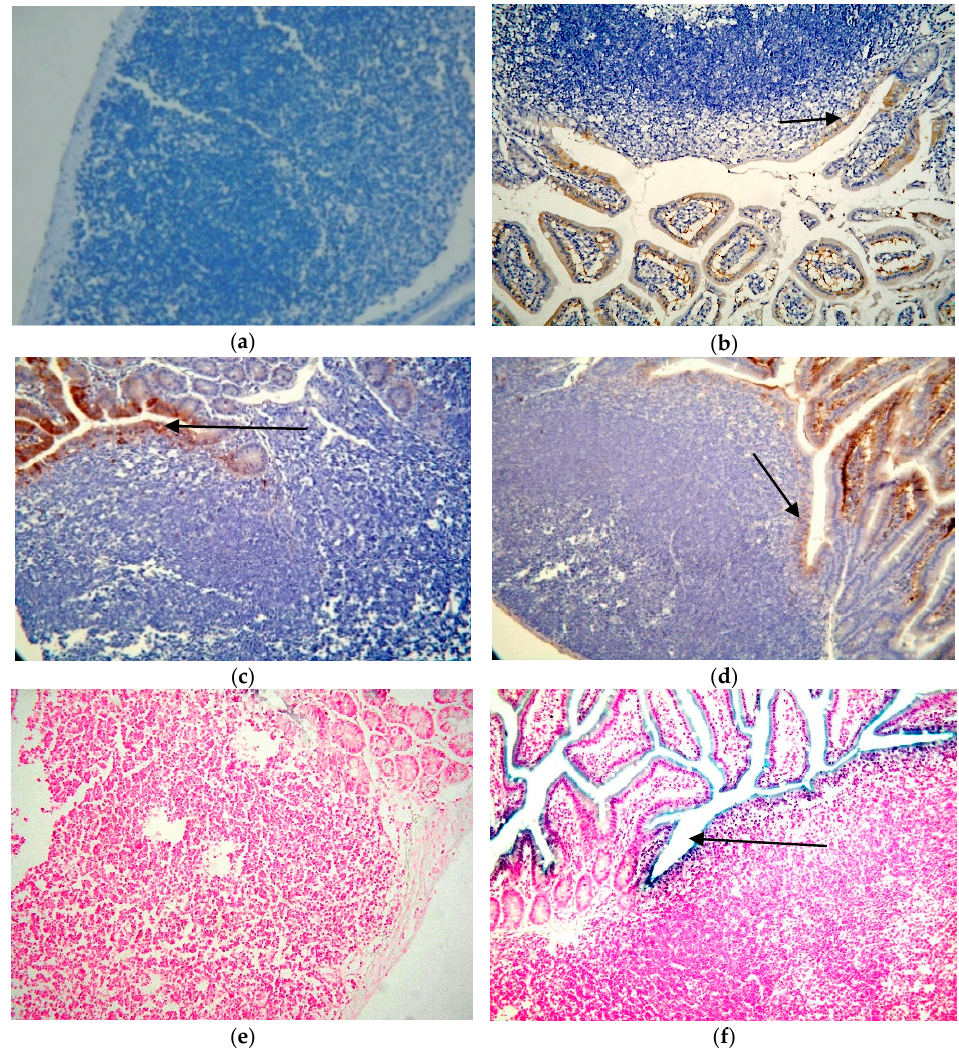
Figure 2. Localization of viral markers in mouse SI tissue sections after CVB infection by immuno- histochemical analysis and in situ hybridization. ( a ) VP1 staining of the SI by method 1 of mock infected control (PBS) (40×); ( b ) SI of orally infected mouse (CVB4-JVB) of Set IIa mice, 4 h p.i. by method 1 (40×); ( c ) tissue section of SI of Set I (CVB3) infected mice stained by using method 2, SI of orally infected day 7 p.i. Arrows show the positivity in the FAE region (40×); ( d ) SI of i.p. infected mouse, day 7 p.i. (40×) ( e ) in situ hybridization of the SI tissue of the control (PBS) (40×), day 3 p.i. after oral infection; ( f ) orally (CVB3 infection) infected mouse of Set I mice 3 days p.i. (60×).